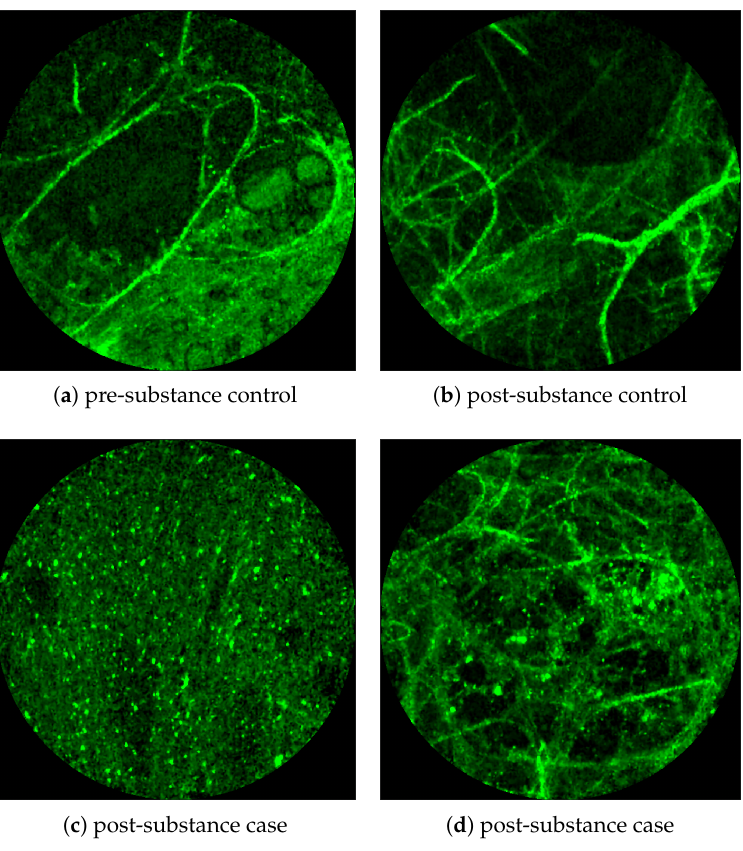
Figure 2. FCFM image frames with or without smartprobe in control or case group. The images are of 600 by 600 microns. The bacteria are usually of 1–2 microns but appear larger due to image